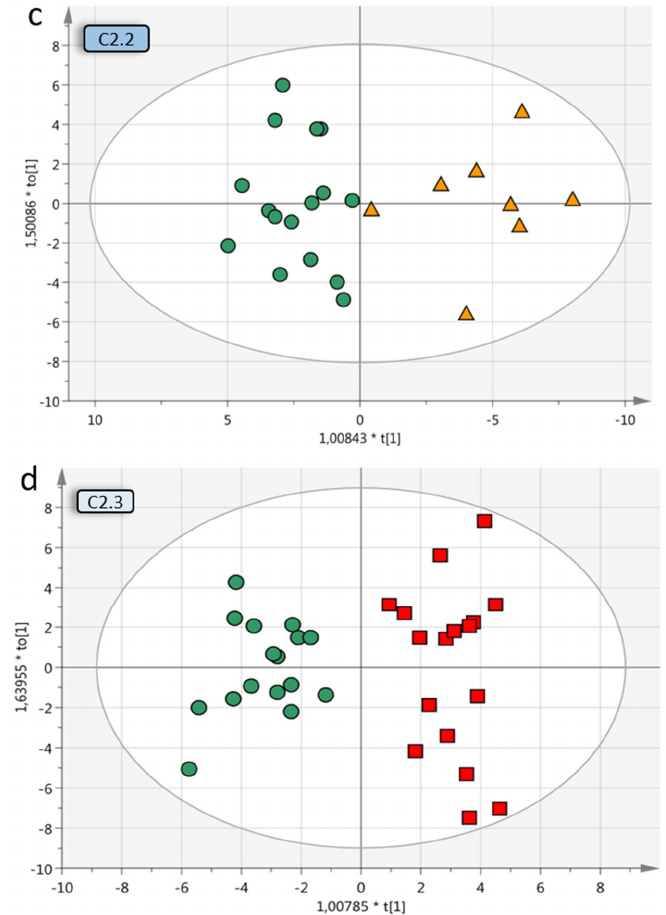
Figure 3. Multivariate OPLS-DA models of OC subgroups. ( a ) Overview of included OC subgroups. The models with higher predictive Q2 values are seen when the OC malignant samples are further divided into subgroups depending on grade, histology and stage. Q2 is the predictive value of the model and varies between 0–1, where > 0.5 indicates a good predictive value for the model. ( b ) OPLS-DA model B2 of benign vs. low-grade OC stage I–II samples (without borderline type tumors) with VIP > 1 (59 variables) and a Q2 value of 0.624, indicating reliable predictability. The individual low- grade samples have been colored according to subgroup for visualization purposes only but were grouped in the analysis. ( c ) Benign vs. HGSC stage I–II (OPLS-DA model C2.2) had a Q2 of 0.513 and ( d ) benign vs. HGSC stage III (model C2.3) had a Q2 of 0.43. For visualization, additional components have been added in c–d, as the optimal Q2 value had 1 + 0 + 0 components. OPLS-DA = orthogonal projection to latent structures-discriminant analysis, OC = ovarian cancer, VIP = variables of importance for projection of plot, LGSC = low-grade serous cancer, HGSC = high-grade serous